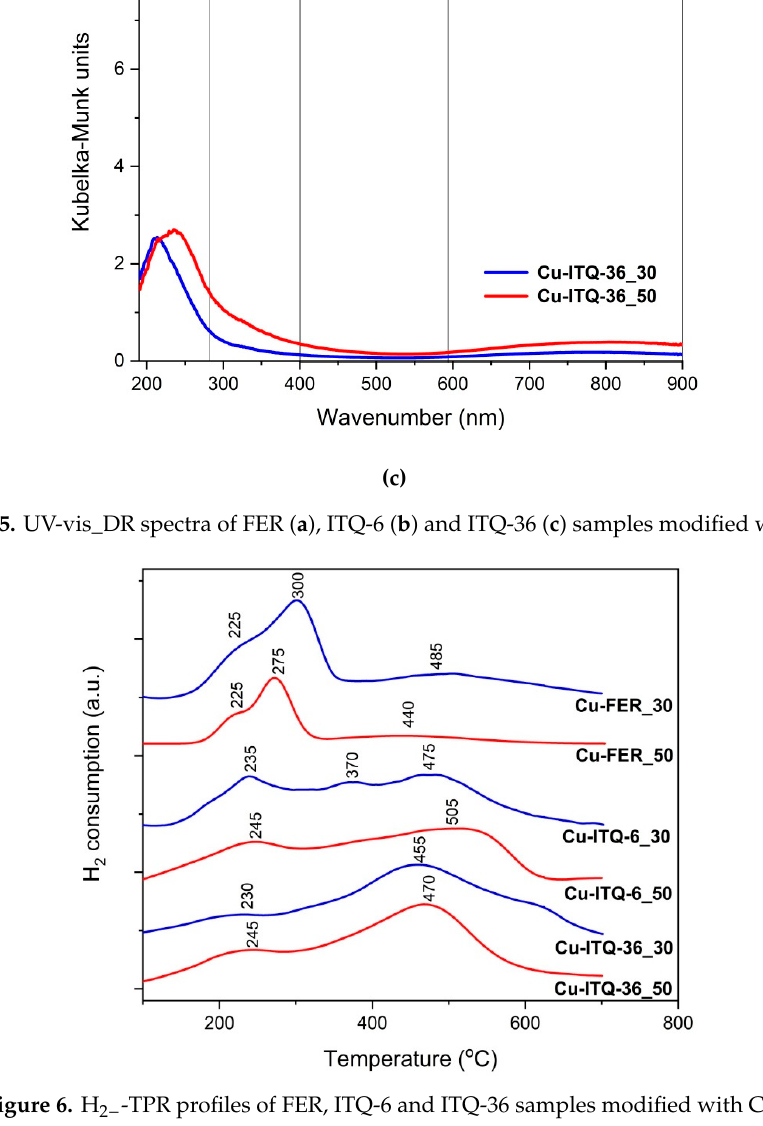
Figure 6. H 2 − -TPR profiles of FER, ITQ-6 and ITQ-36 samples modified with Figure 6. H 2- -TPR profiles of FER, ITQ-6 and ITQ-36 samples modified with Cu.